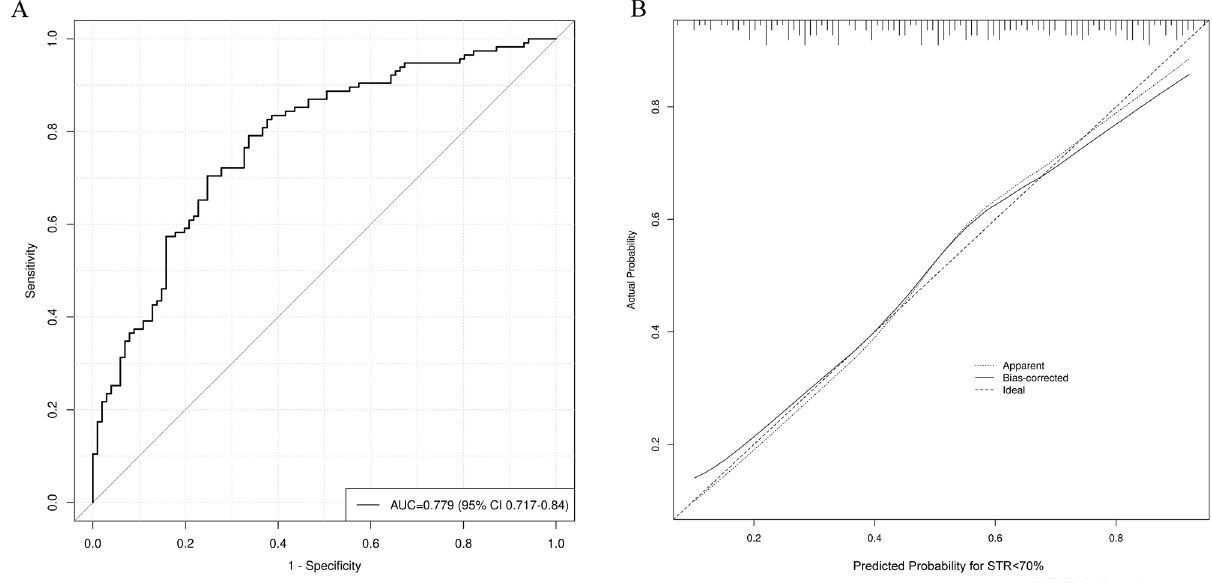
Figure 6. ROC curve ( A ) and calibration curve ( B ) of the nomogram